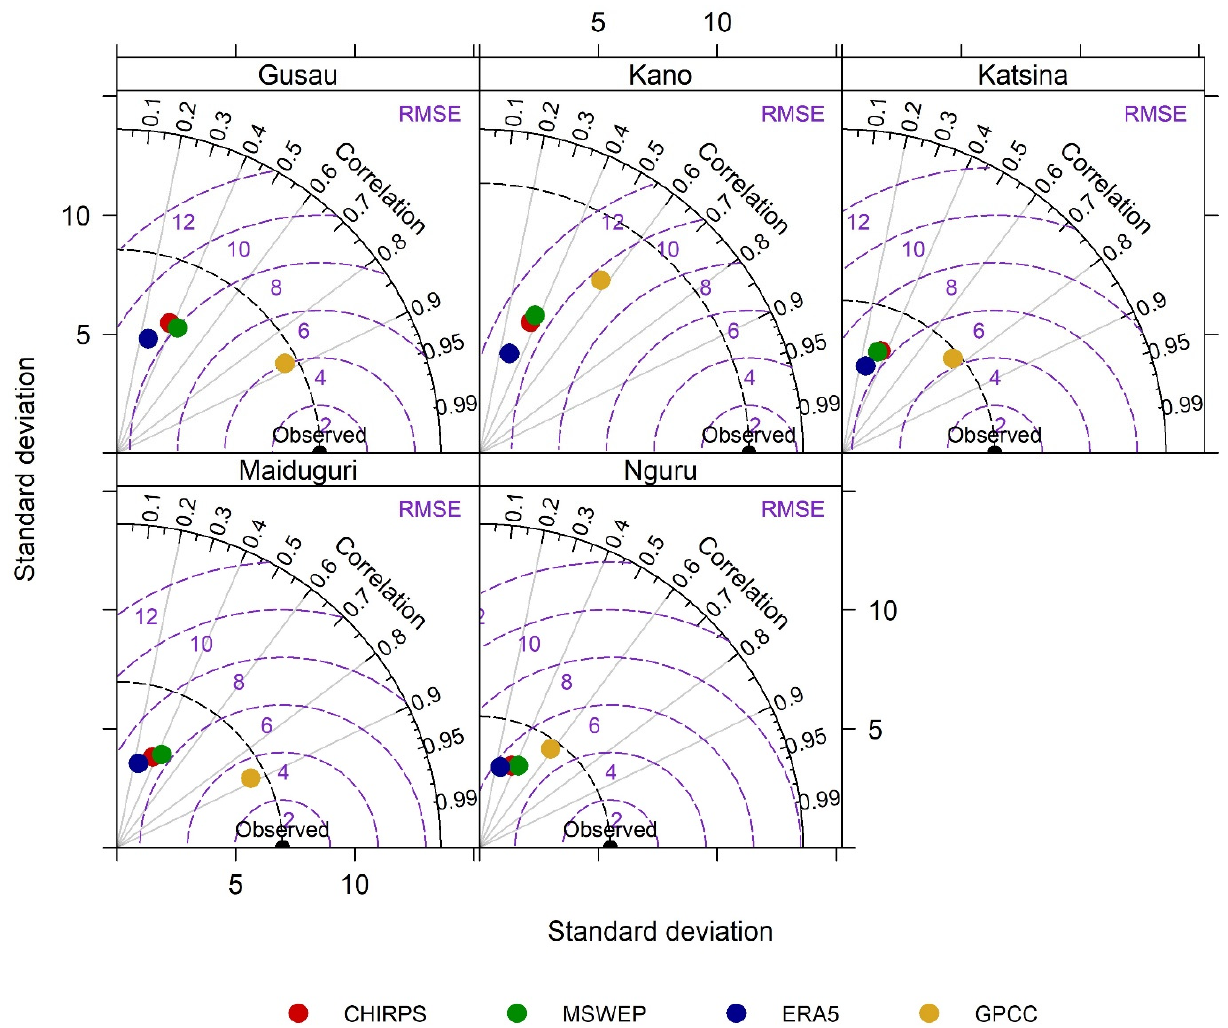
Figure 3. Taylor diagram of synoptic stations within the Sahel climatic zone.